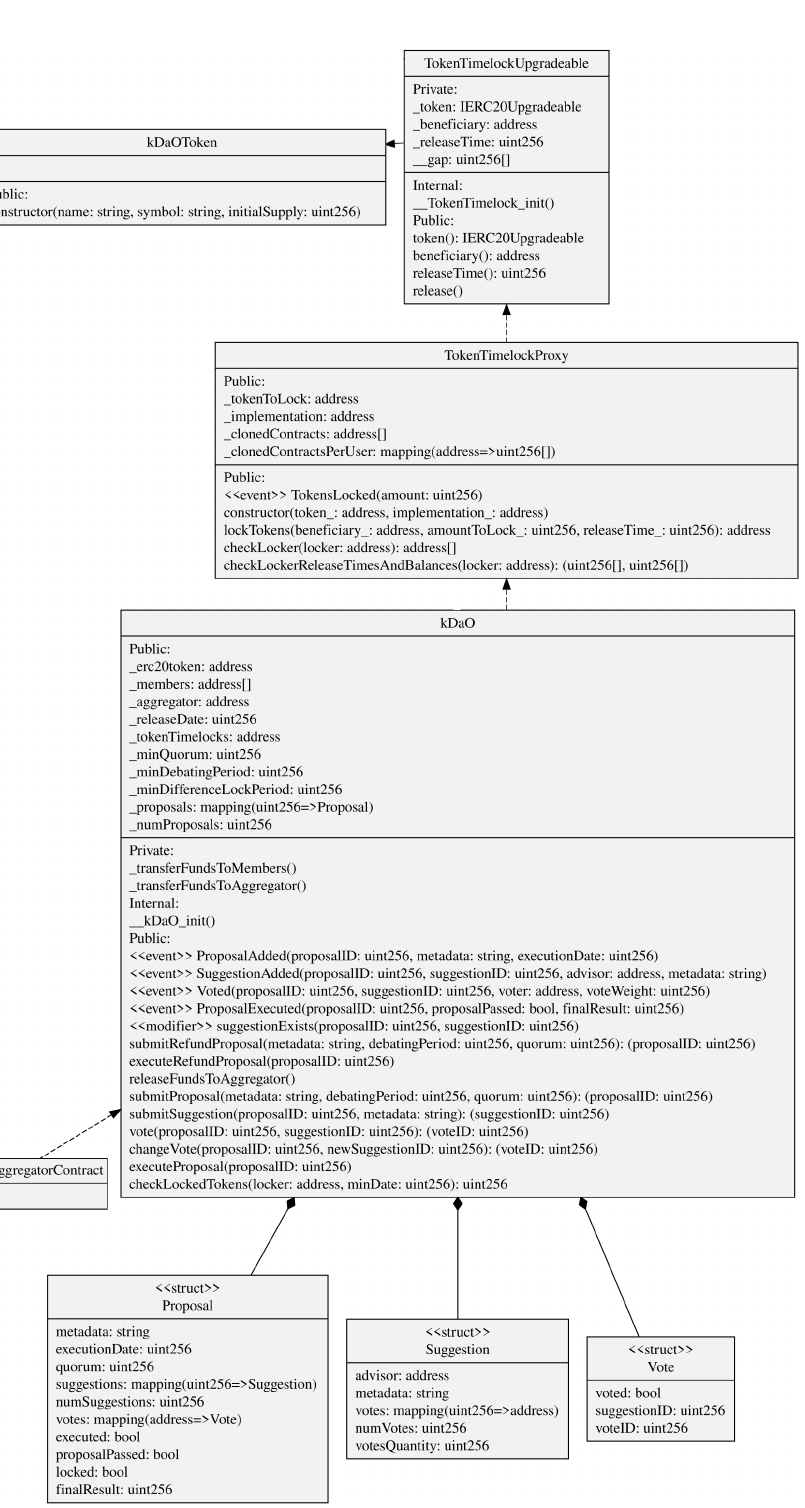
Figure 8. UML Class Diagram of kDaO , TokenTimelockProxy , TokenTimelockUpgradeable and kDaOToken . Some classes, attributes and methods have been removed to render the diagram